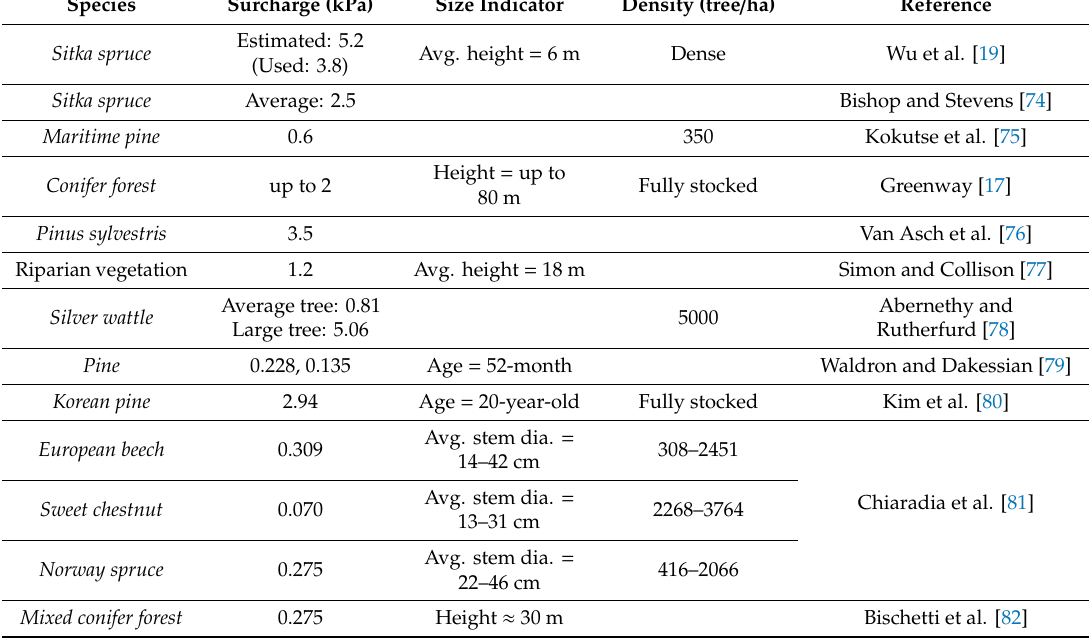
Table 3. The surcharge value due to the weight of